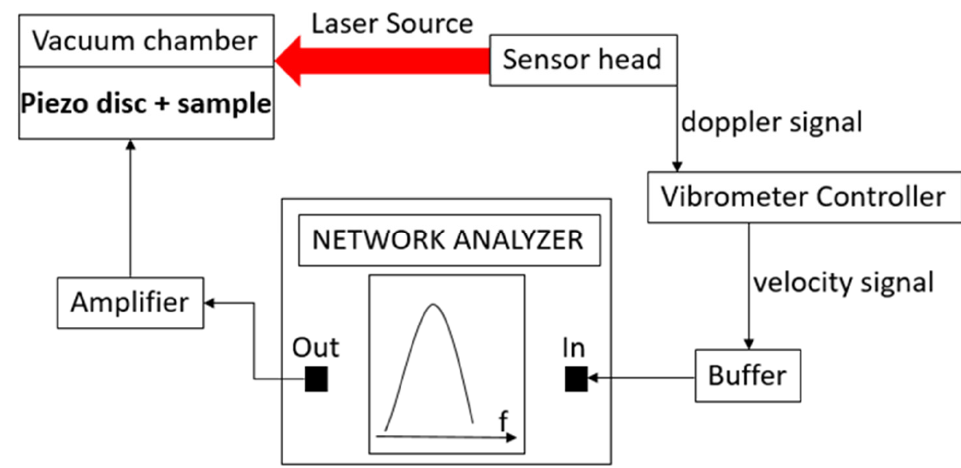
Figure 3. Schematic of the experimental setup used to measure the resonance frequency of the double clamped beams.